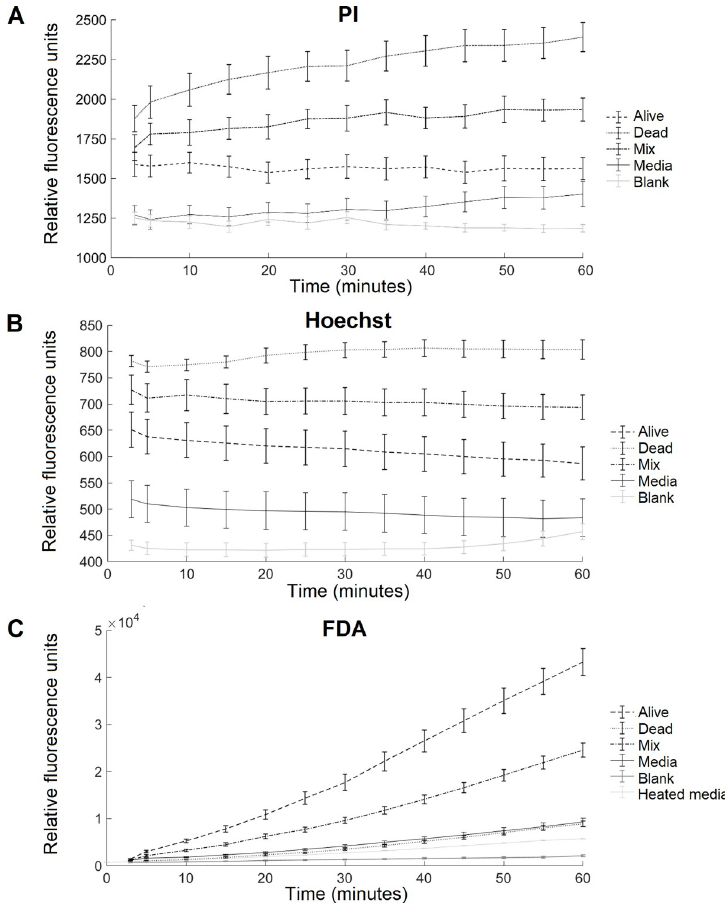
Fig 4. Fluorescence of PI (A), Hoechst (B) and FDA (C) stained cercariae over time. Each sample contains 100 ± 4 cercariae. Dead cercariae were heat-killed at 60˚C for 5 minutes, and mixed samples contain 50% alive and 50% dead cercariae. Data points and error bars show the mean and SEM of nine wells (experiments run in triplicate and repeated three times).